Question: Identify the chart type used in this figure.
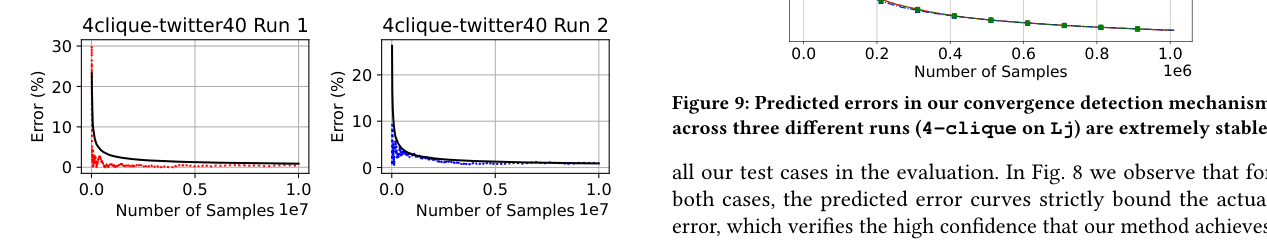
Answer: line